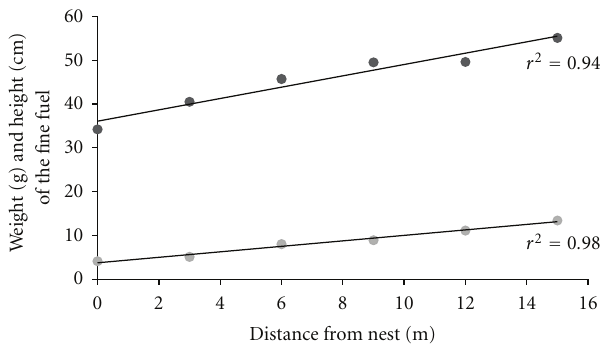
Figure 1: Litter mass (g) and height (cm) of small woody debris ( ≤ 5cm) as a function of distance from leaf-cutter ant nests in a forest at the Amazon-Cerrado transition. Black circles: litter mass; gray circles: height of small woody debris, N = 6.